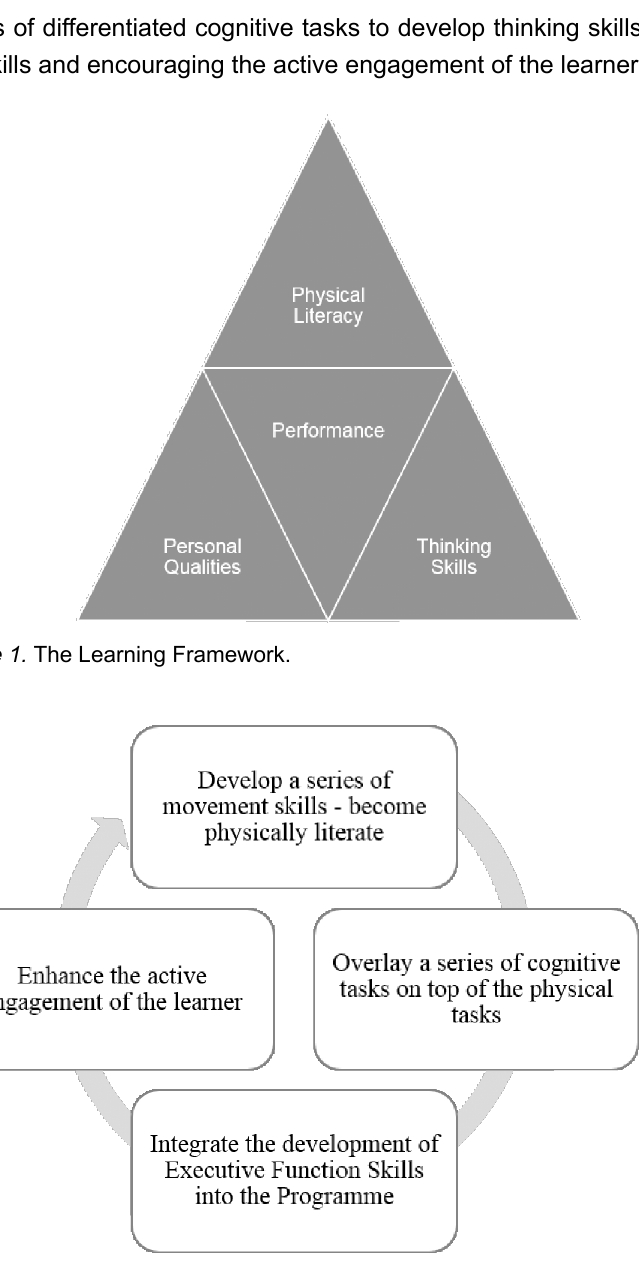
Figure 2. The BMT